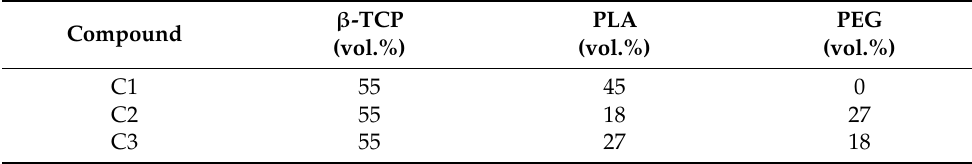
Table 1. Composition of the three different compounds C1, C2, and